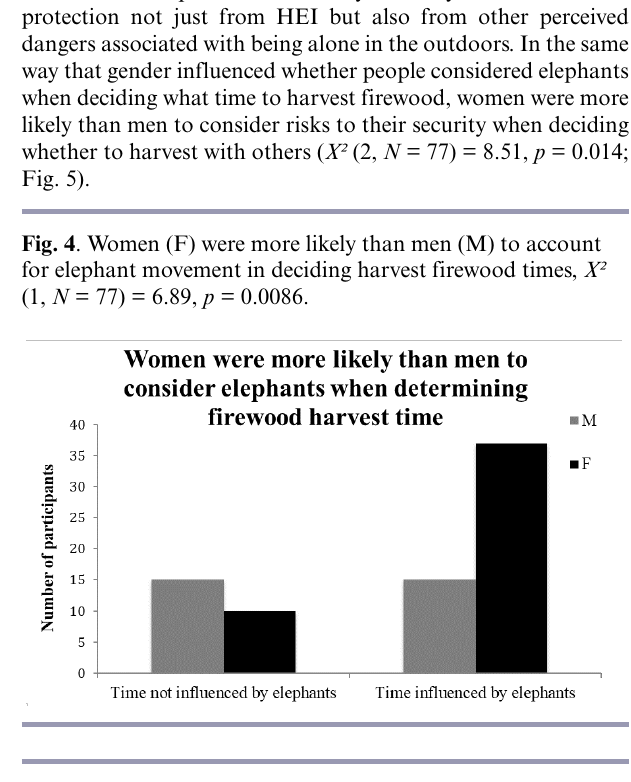
Fig. 5 . Women were more likely to consider risk when deciding whether to harvest alone or with others, X² (2, N = 77) = 8.51, p =